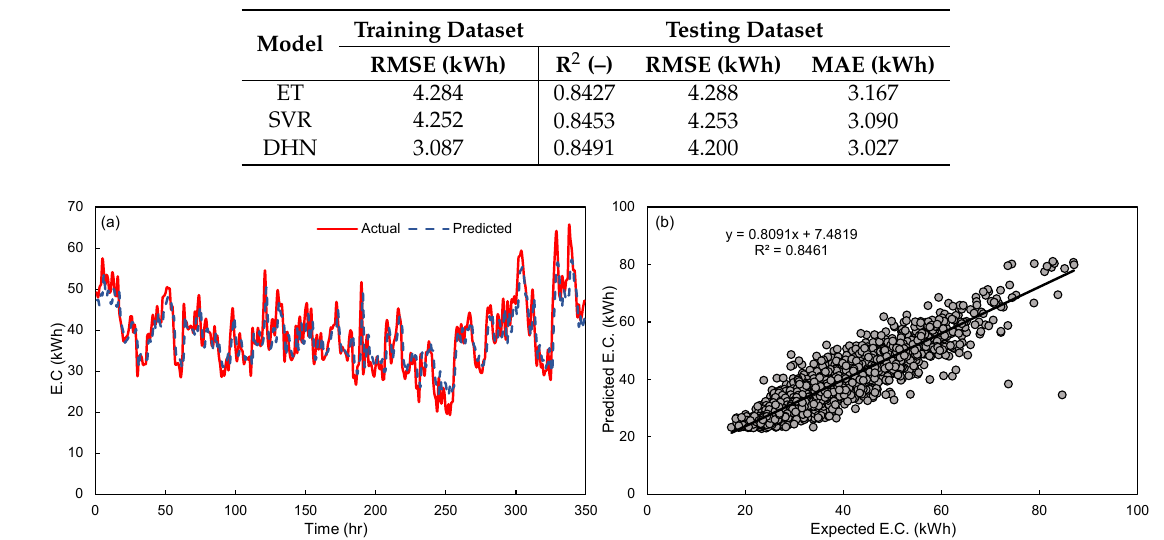
Table 10. Comparison of extremely randomized trees (ET), support vector regression (SVR) and deep highway network (DHN) models.